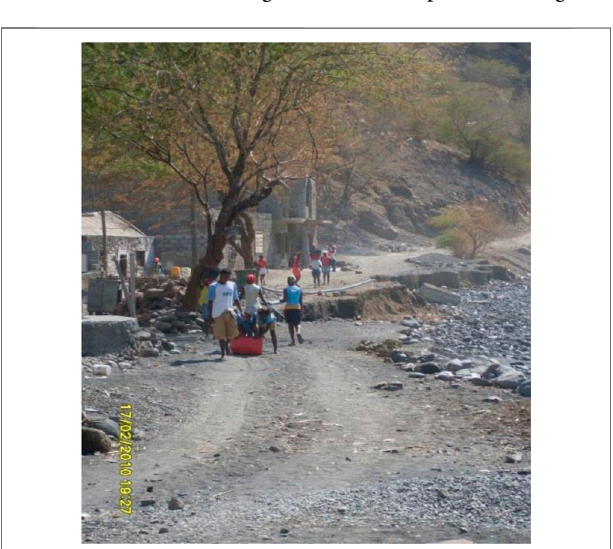
10 Arab Bank for Economic Development in Africa. 11 Water time, i.e., the rainy season in which irrigated agriculture is dedicated and runs from July to